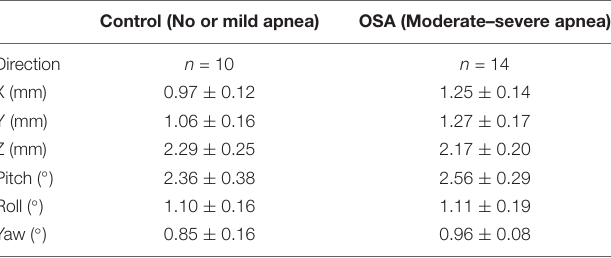
TABLE 2 | Translational and rotational head movement during simulated apnea.